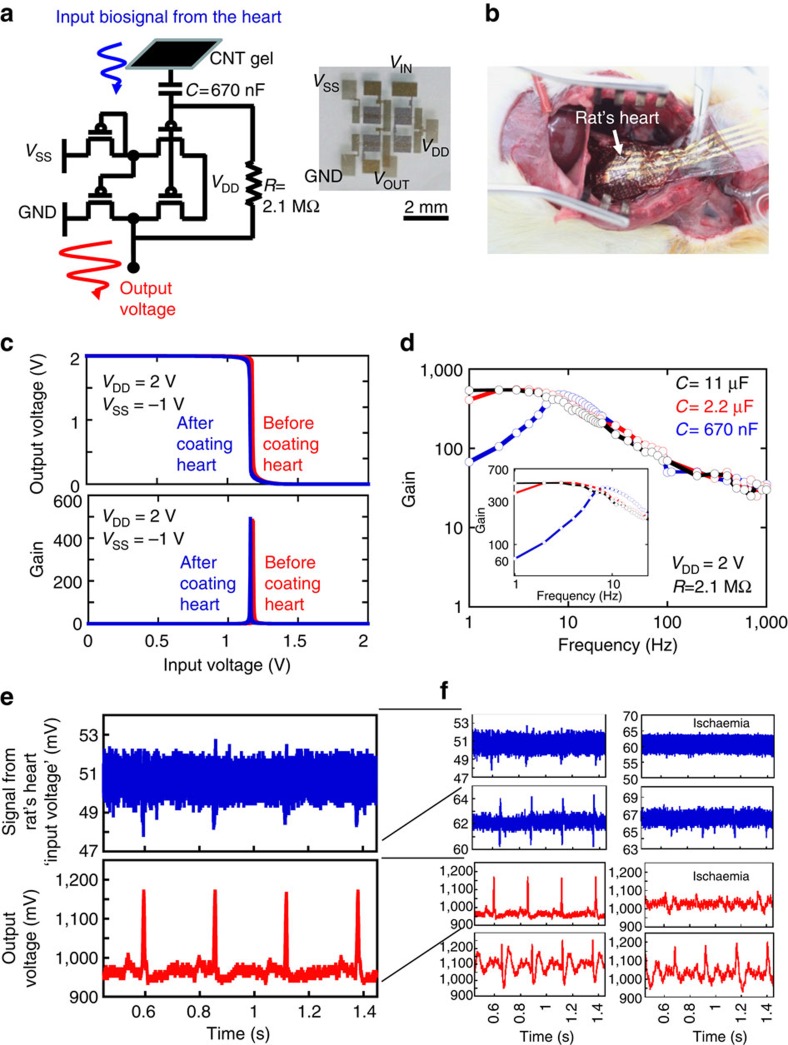
Electrocardiogram using conductive gel probes and ultraflexible organic circuit.(a) Circuit diagram of one cell of an organic amplifier with a conductive gel for in vivo electrocardiograph comprising an organic pseudo-CMOS inverter that works as an amplifier, where VDD is the power source voltage, VSS is the tuning voltage, L is the channel length and W is the channel width. Photograph of an organic pseudo-CMOS inverter is also shown. (b) Photograph of ultraflexible circuits (pseudo-CMOS inverter) on the rat heart. (c) Characteristics of the pseudo-CMOS inverter before and after coating the rat heart. The electrical performance does not change after coating. (d) Frequency responses of the gain of an organic amplifier by varying the input capacitor (c) from 0.67 to 2.2, to 11 μF. (e). Amplification performance and (f) the magnified characteristics of the organic amplifier. (Blue line) Input signal is directly obtained from the heart where CNT conductive gel is used for the electronic interface. (Red line) Output signal is amplified using an organic amplifier. An input signal of 1.2 mV is amplified to a 220-mV output signal. A series of electrocardiograms is also shown in the right. An ischaemia-induced myocardial infarction is clearly observed. The total thickness of the cardiac electrodes is ∼1 mm, while the size is 6 mm × 6 mm, which was determined by the size of a pixel of an organic amplifier (Fig. 5 and Supplementary Fig. 16).